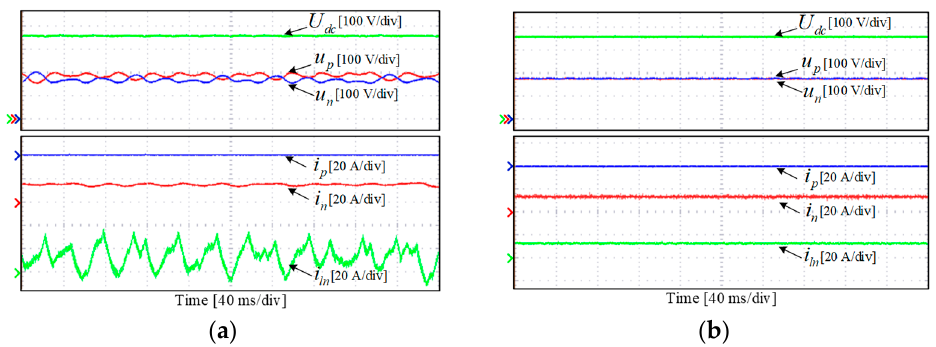
Figure 12. Experimental results of different DPC strategies under an unbalanced load condition. ( a ) Classic DPC strategy and ( b ) proposed DPC strategy.